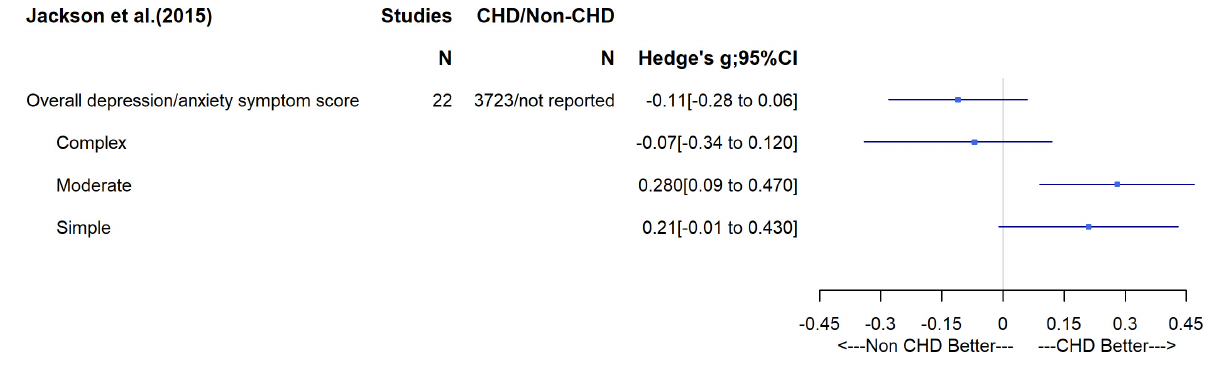
FIGURE 3 | Differences in mean depression/anxiety symptom score and subgroup analysis on complexity of disease.